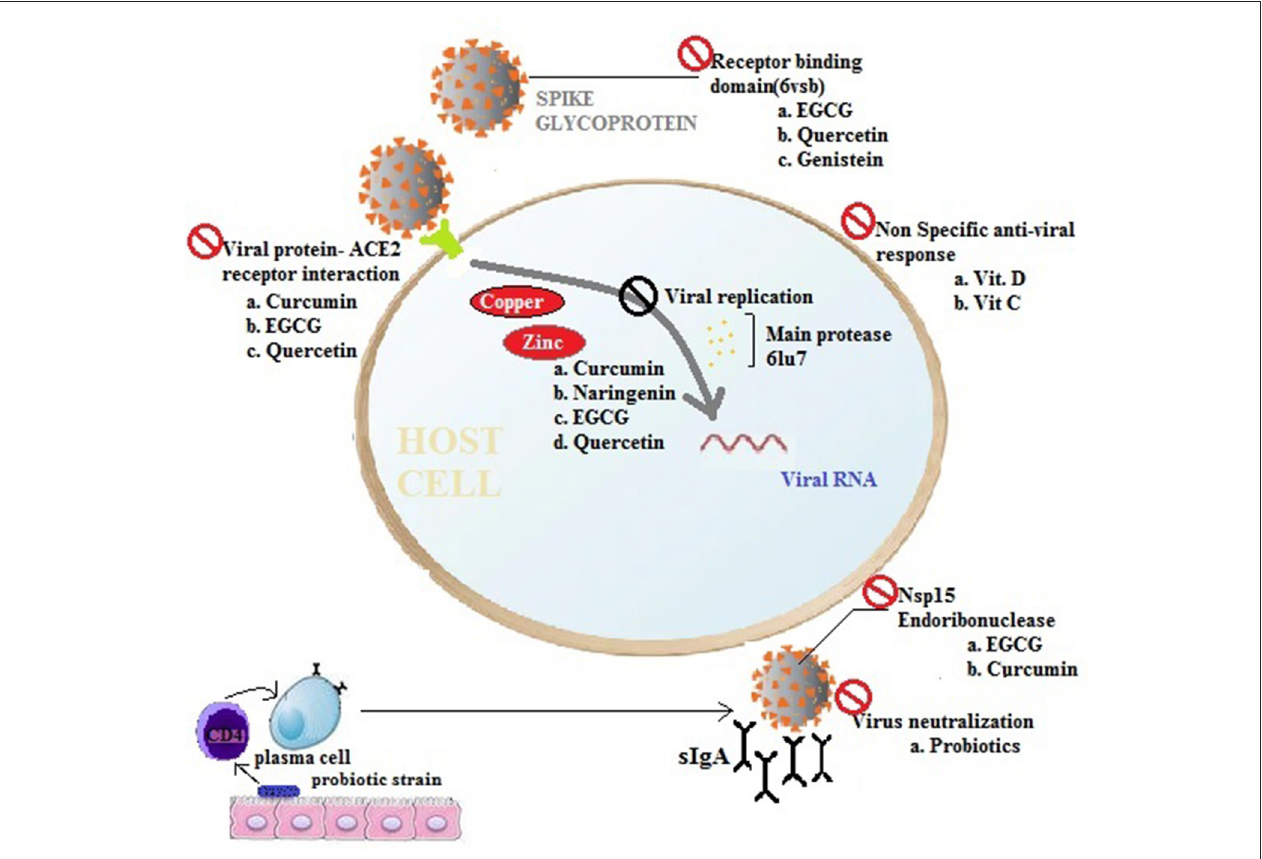
FIGURE 1 | The potency of nutraceuticals and functional foods for preventing viral infections. Pre-intervention as supplements or in combinations with nutraceuticals and nutrient supplements modulate immune responses and prevent viral infections or ameliorate disease severity by acting at different stages of a virus invasion pathway (Nsp15, SARS-CoV-2 endoribonuclease; 6vsb, 2019-nCoV spike glycoprotein; 6lu7, SARS-CoV-2 main protease, ACE2, receptor for SARS-CoV-2; EGCG, Epigallocatechin